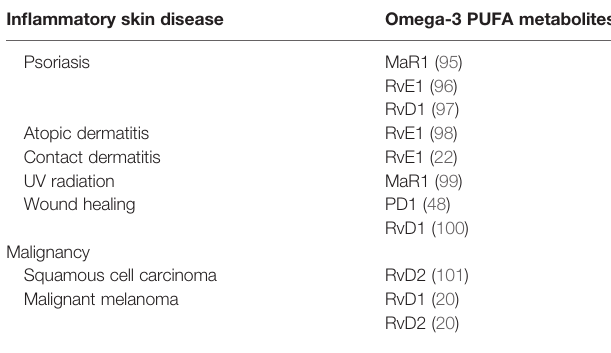
TABLE 2 | Anti-in fl ammatory and anti-tumor action of Omega-3 PUFA metabolites in skin